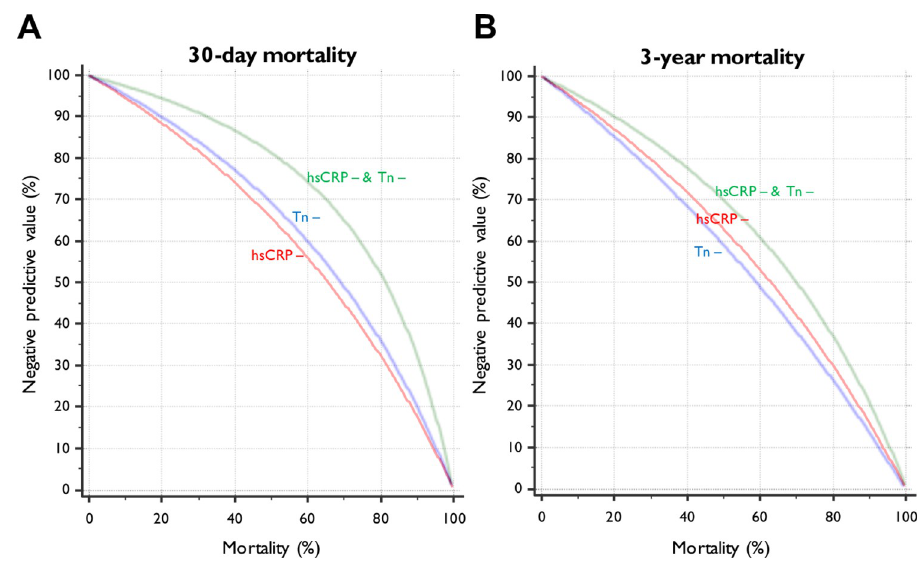
Fig 4. Relationship between negative predictive value of hsCRP and troponin testing with (A) 30-day and (B) 3-year mortality. hsCRP, high-sensitivity C-reactive protein; hsCRP − , negative high-sensitivity C-reactive protein; Tn − , negative